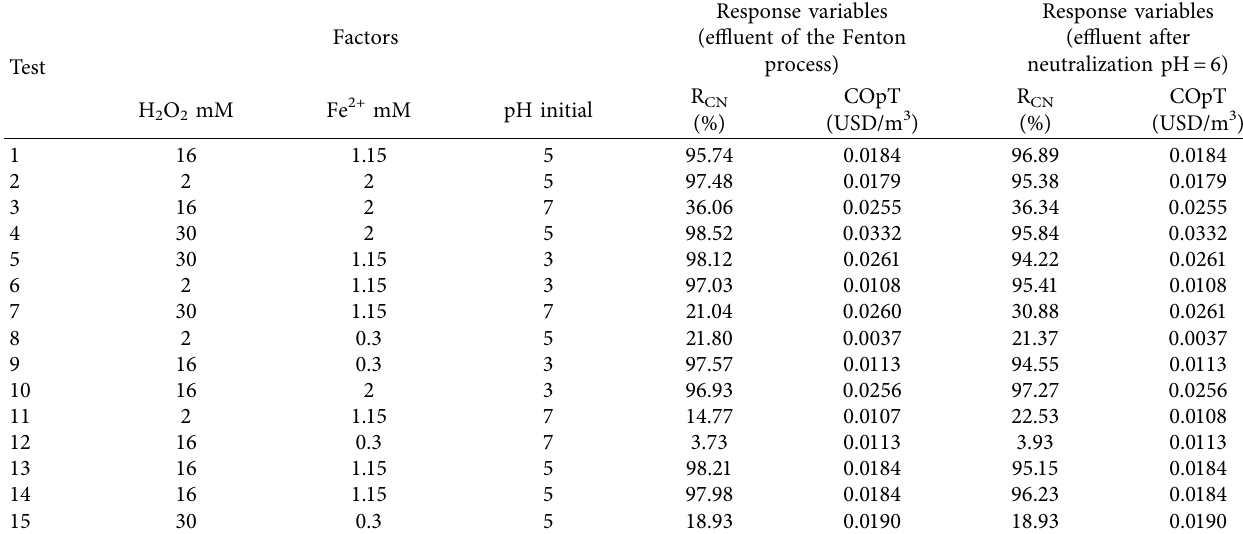
Table 3: Analysis of variance for the %R